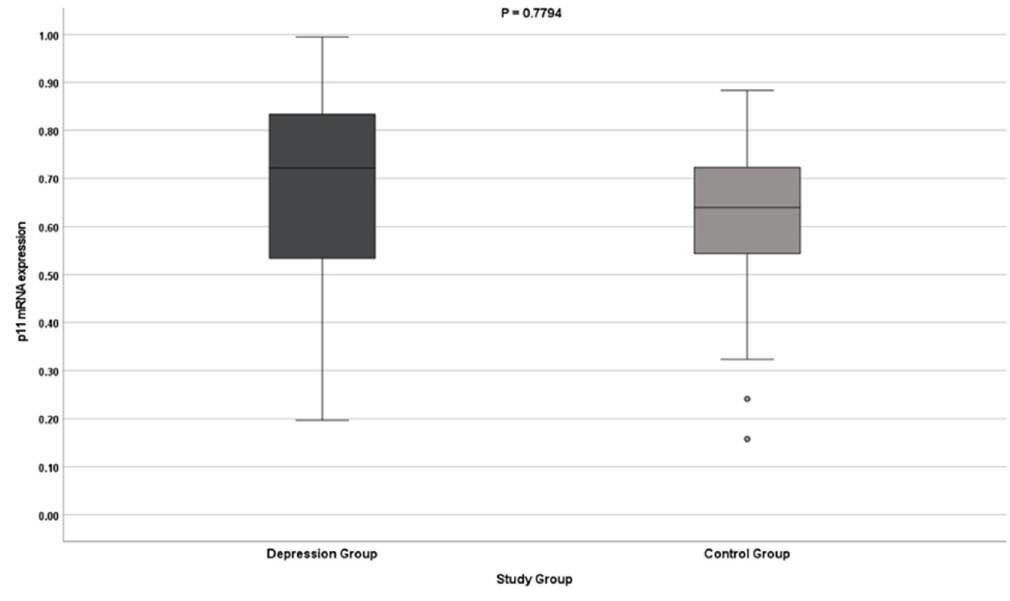
Figure 2. p11 gene mRNA expression. Table 3. Spearman’s rho correlations of p11 gene expression with clinical variables in the test group (depression).